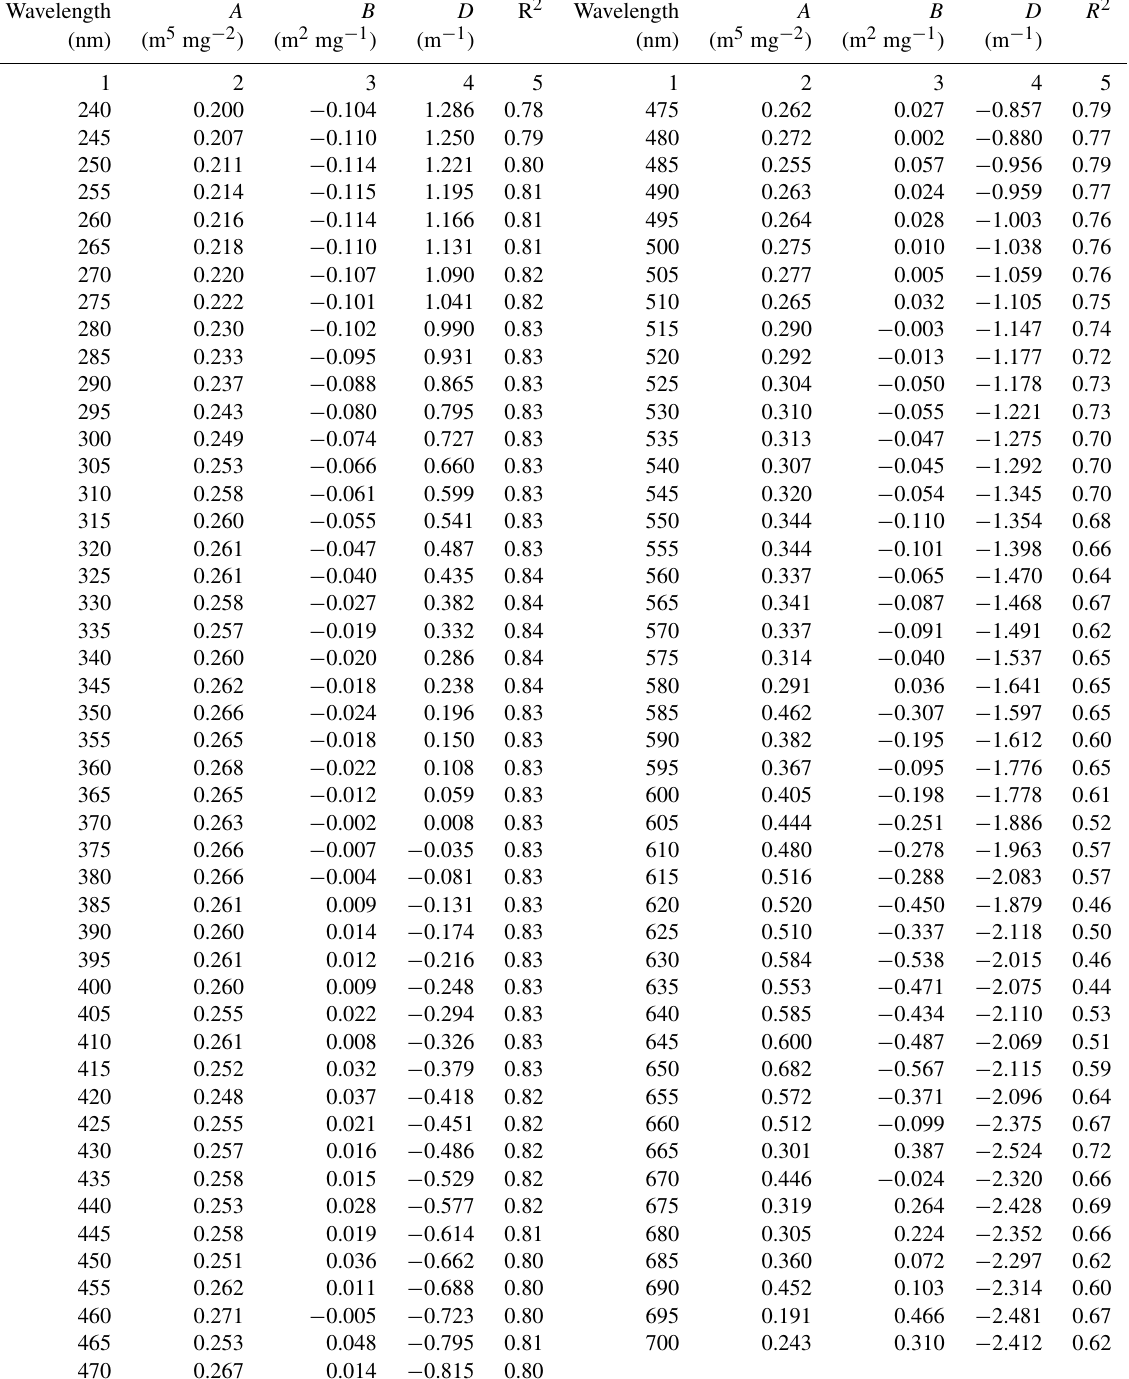
Table A1. Model parameters for light absorption by CDOM (Eq. 13) for the wavelength range 240–700nm shown for intervals of